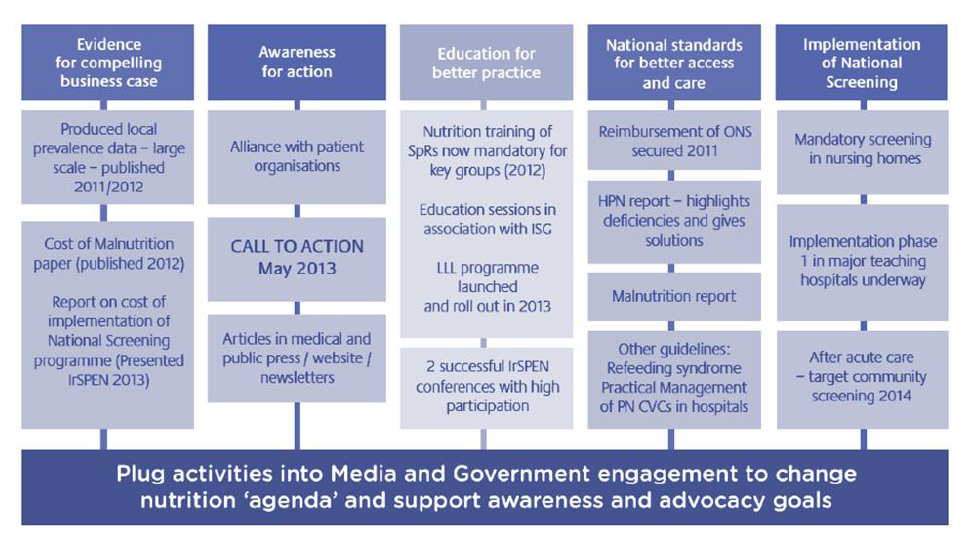
Figure 1. Irish Society for Clinical Nutrition and Metabolism (IrSPEN) adopted a